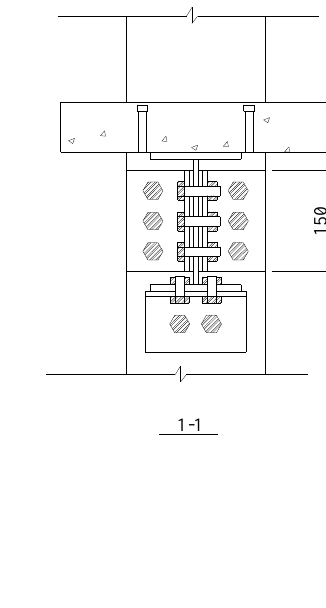
Figure 14. The static and dynamic responses of M0-RS1-8, M0-RS1-10, M0-RS1-12, and unenhanced